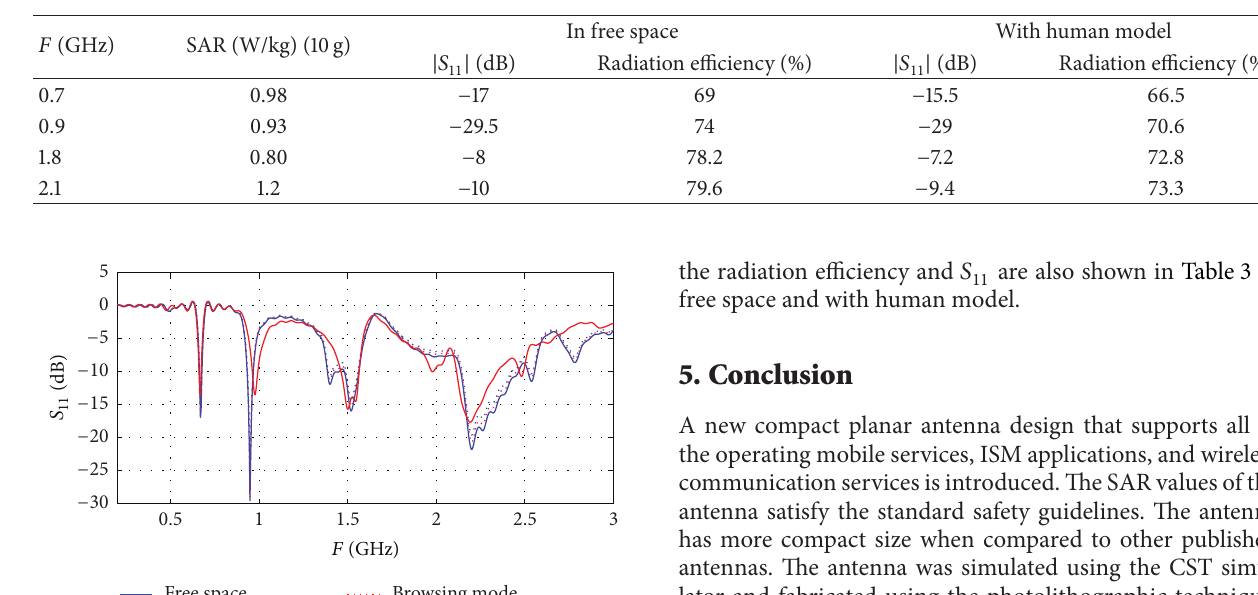
Table 4: SAR values and the effects of human model on antenna properties.